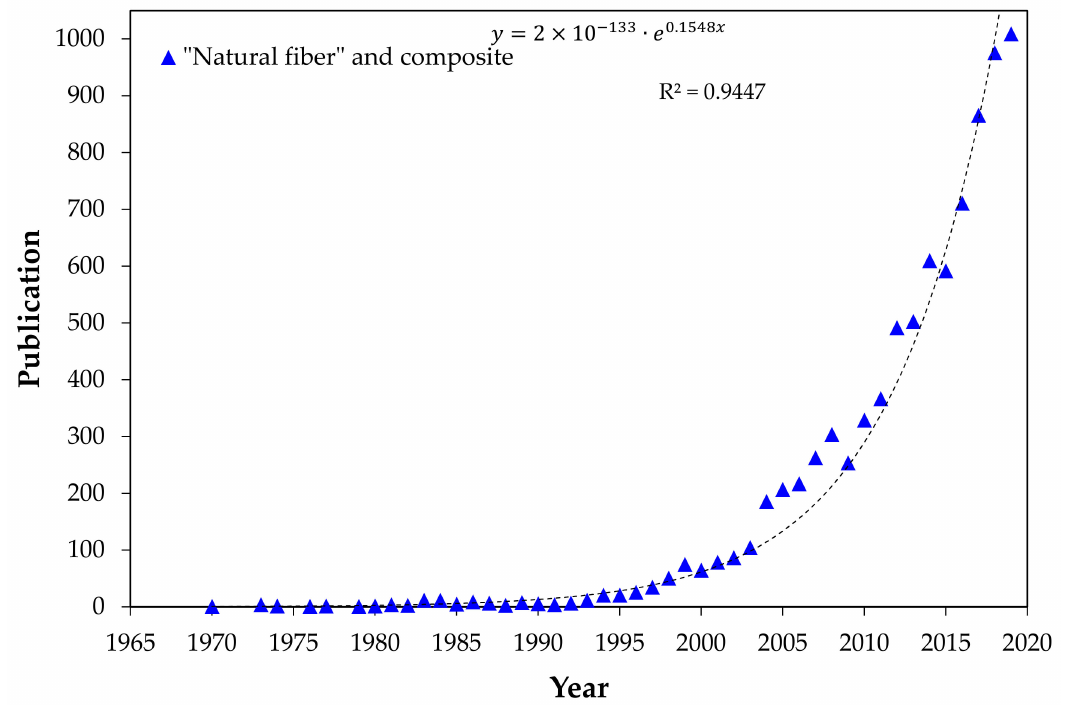
Figure 1. Publication by year for “Natural fiber and composite” according to the Scopus database [13].